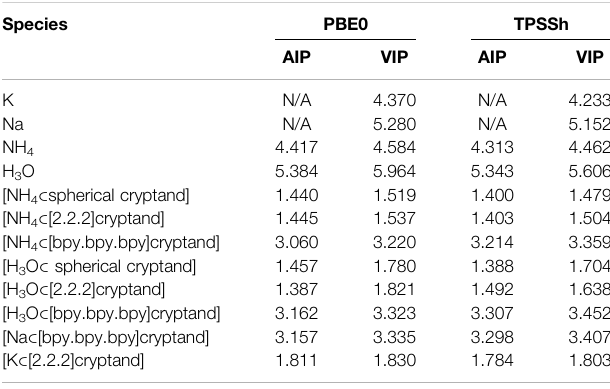
TABLE3| ValuesofVIPandAIP[eV]obtainedusingPBE0andTPSShfunctionals with def2-TZVPPD basis set. Species PBE0